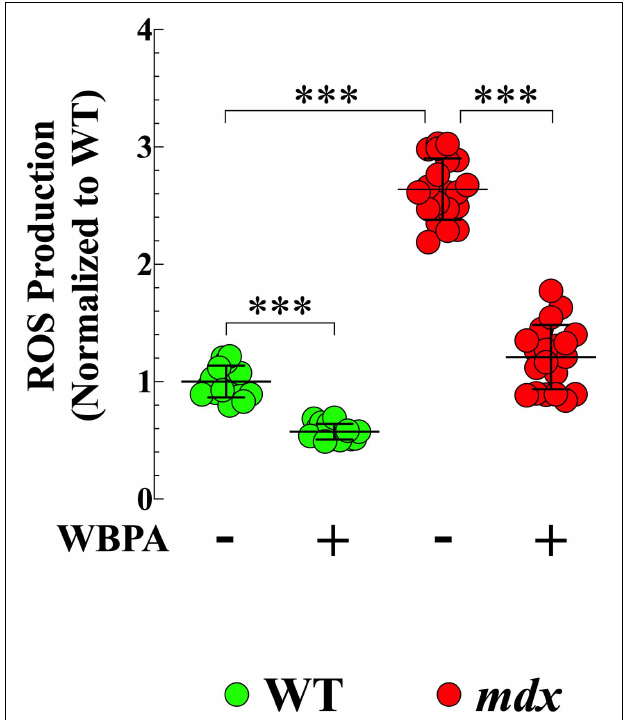
FIGURE 2 | Whole body periodic acceleration reduced ROS generation in cardiomyocytes. Cardiomyocytes ROS production was evaluated in 15-month WBPA-treated and untreated WT and mdx dystrophin-deficient mice. Intracellular ROS was 2.6-fold higher in mdx cardiomyocytes than WT. WBPA treatment reduced intracellular ROS production by 2.7-fold in mdx cardiomyocytes and by 1.7-fold in WT cardiomyocytes compared to untreated mdx and WT cardiomyocytes. ROS measurements : Untreated and WBPA-treated WT, N = 3 mice per experimental conditions , n = 13–15, respectively. Untreated and WBPA-treated mdx N = 3 mice per experimental conditions , n = 17–20, respectively. Values are expressed as means ± S.D. One-way ANOVA with Tukey’s post-test, *** p ≤ 0.001.